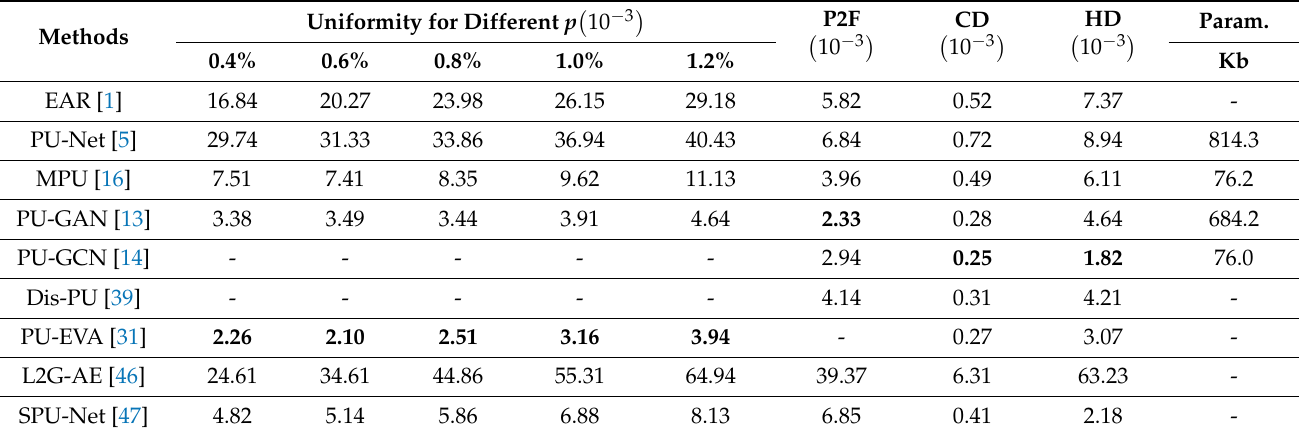
Table 3. Quantitative comparison of different network models. Bold denotes the best performance.